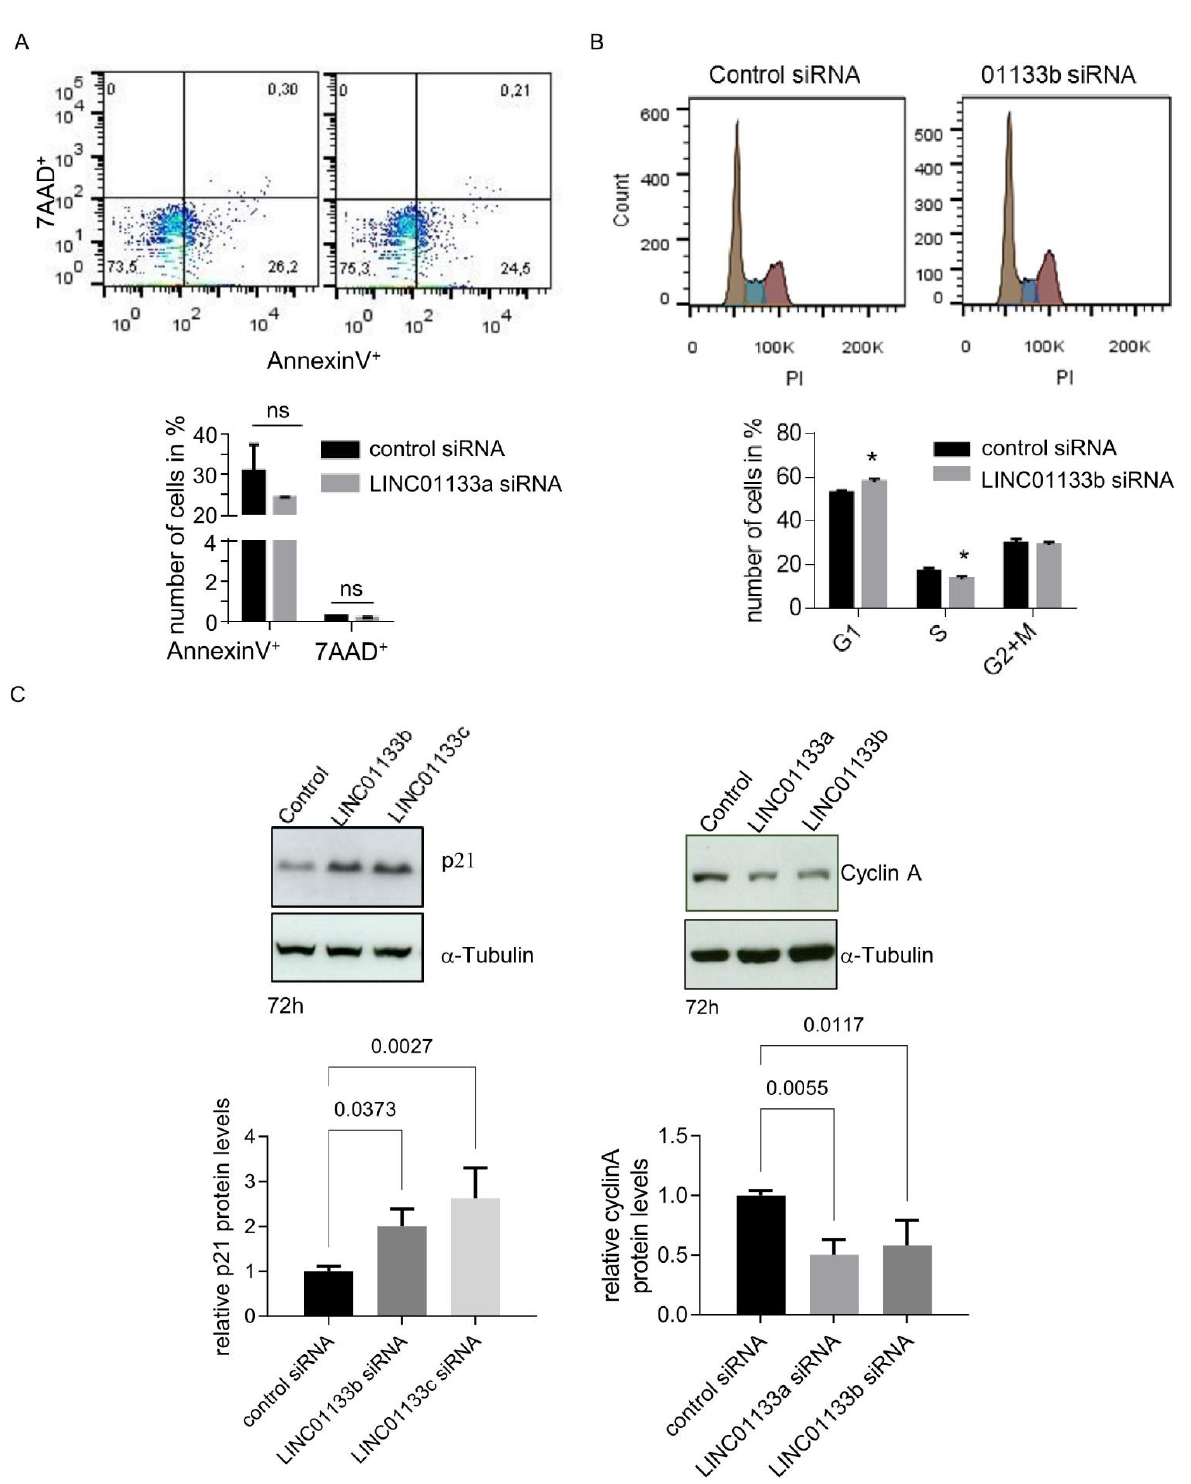
Figure 4. LINC01133 knockdown leads to an increase in cells in the G1 phase and a decrease in cells in the S phase associated with an increase in p21 and a decrease in Cyclin A levels. ( A ) No significant changes in the number of apoptotic cells are seen 72 h after LINC01133 knockdown. Top: Representative flow cytometry scatter plots for AnnexinV+ versus 7-AAD+ cells. Bottom: No significant change in the number of AnnexinV+ or 7AAD+ cells was observed between LINC01133a knockdown and control siRNA transfected cells. Mean values + SD of three biological replicates are shown. ( B ) LINC01133 knockdown leads to an increase in cells in the G1 phase and a decrease in cells in the S phase. Top: Representative DNA